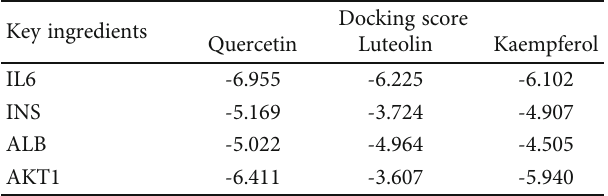
Table 2: Docking score.